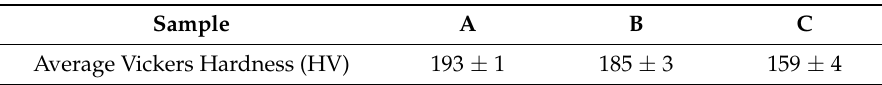
Table 5. Uniform specimen hardness testing results.